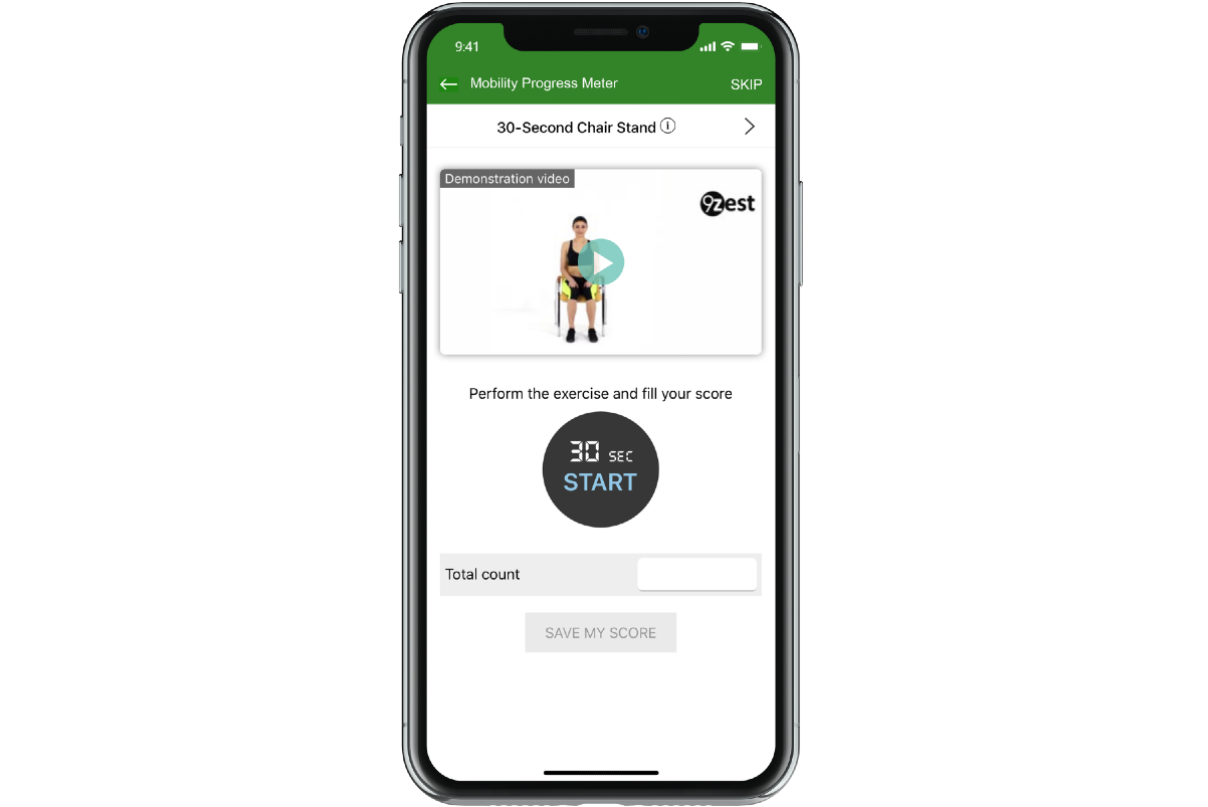
Figure 1. An example (30-second Sit-To-Stand test) of the in-app performance-based assessment used as a primary endpoint for the study and also used by the 9zest Smart to construct the exercise